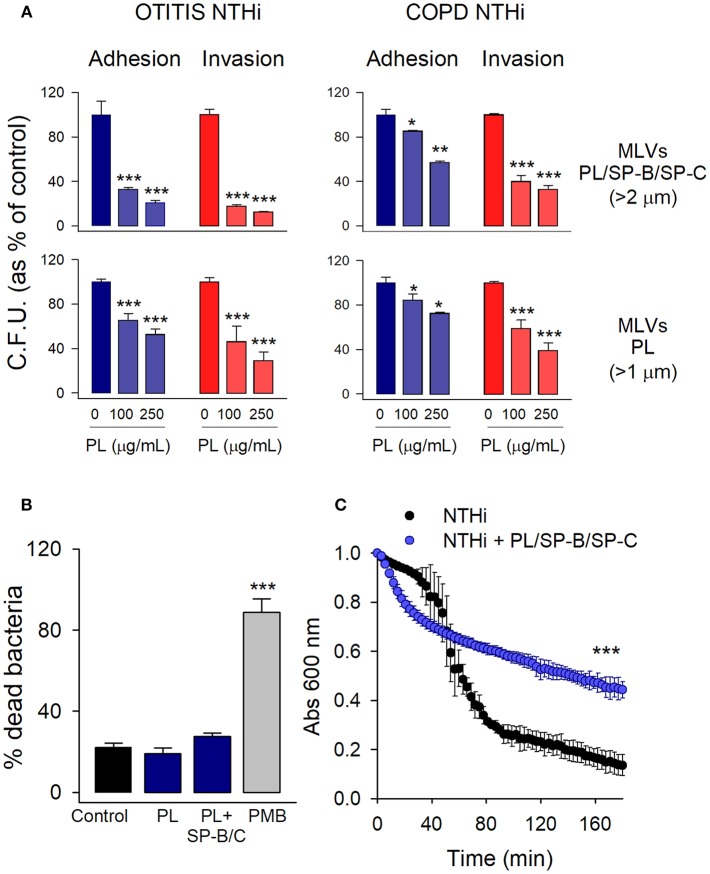
Extracellular multilamellar vesicles of pulmonary surfactant inhibit adhesion of NTHi to pneumocytes and decrease NTHi self-aggregation. (A) MLE-12 cells were infected with NTHi clinical strains from patients with otitis media and COPD, in the presence or absence of MLVs (100 or 250 μg PL/ml) prepared from either the hydrophobic fraction of native surfactant (PL/SP-B/SP-C) or a mixture of surfactant lipids (PL). For adhesion experiments, cells were infected for 30 min, washed, and lysed. For invasion assays, cells were infected for 2 h, washed, and incubated for an additional 1 h with gentamicin to kill extracellular bacteria. The resulting lysates were plated on sBHI agar. Colonies were counted and the results were expressed as percentages of C.F.U. relative to infected cells in the absence of lipids. Results are mean ± SEM of three independent experiments run in triplicate. ANOVA followed by Bonferroni multiple comparison test was used. *p < 0.05, **p < 0.01, and ***p < 0.001 when compared with NTHi-infected pneumocytes in the absence of lipids. (B) NTHi (otitis strain) were incubated in the presence or absence of MLVs (250 μg/ml) composed of either a mixture of surfactant lipids (PL), or the hydrophobic fraction of native surfactant (PL/SP-B/C) for 30 min. Bacteria were then stained with carboxyfluorescein diacetate succinimidyl ester (green), and bacterial viability was assessed by propidium iodide exclusion. Polymixin B (PMB) (20 μg/ml) was used as a positive control of bacterial killing. Data were expressed as % of dead bacteria. Results are mean ± SEM. ANOVA followed by the Bonferroni multiple-comparison test was used. ***p < 0.001 vs. untreated bacteria. (C) Effect of surfactant vesicles on NTHi self-aggregation. NTHi (otitis strain) was incubated in the presence or absence of MLVs (250 μg PL/ml) prepared from the hydrophobic fraction of native surfactant. Bacterial aggregation was monitored by measuring the decrease of absorbance at 600 nm every 3 min. Four independent experiments were performed. Results are mean ± SEM. Student's t-test was used. ***p < 0.001.